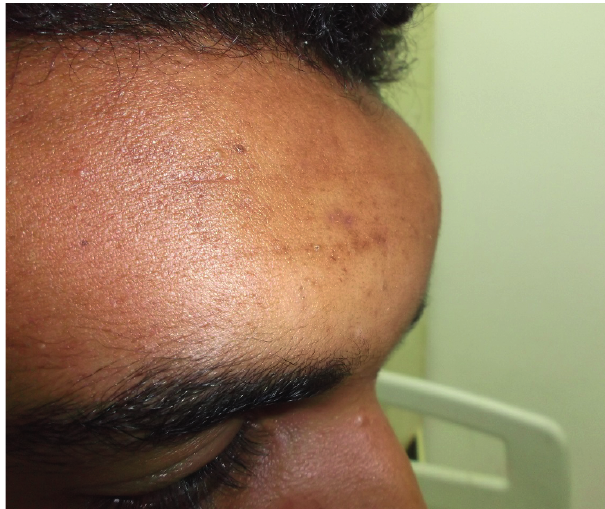
Figure 1. Clinical demonstration of Pott's puffy tumor.